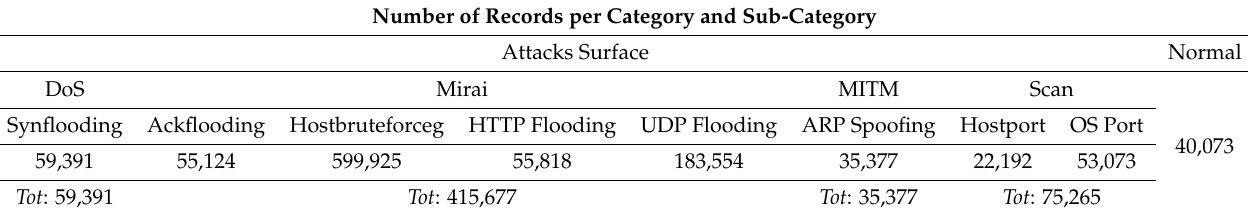
Table 1. Dataset records distribution per category/subcategory. Number of Records per Category and